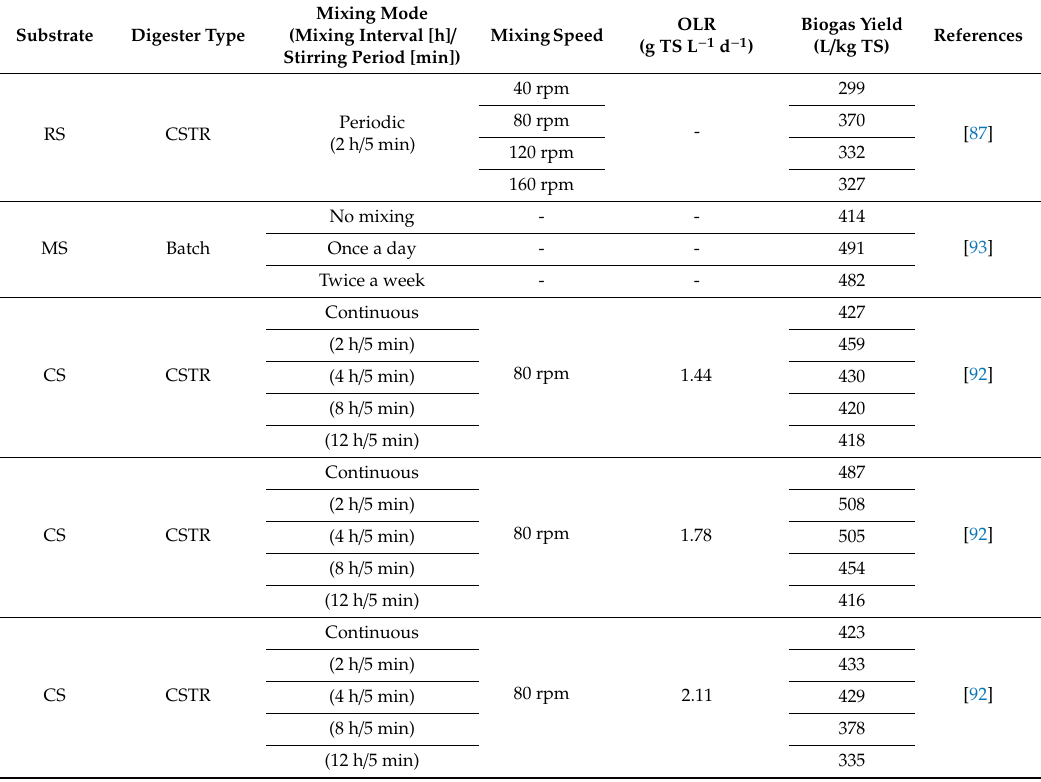
Table 7. E ff ects of mixing on the biogas yield in AD of rice and other